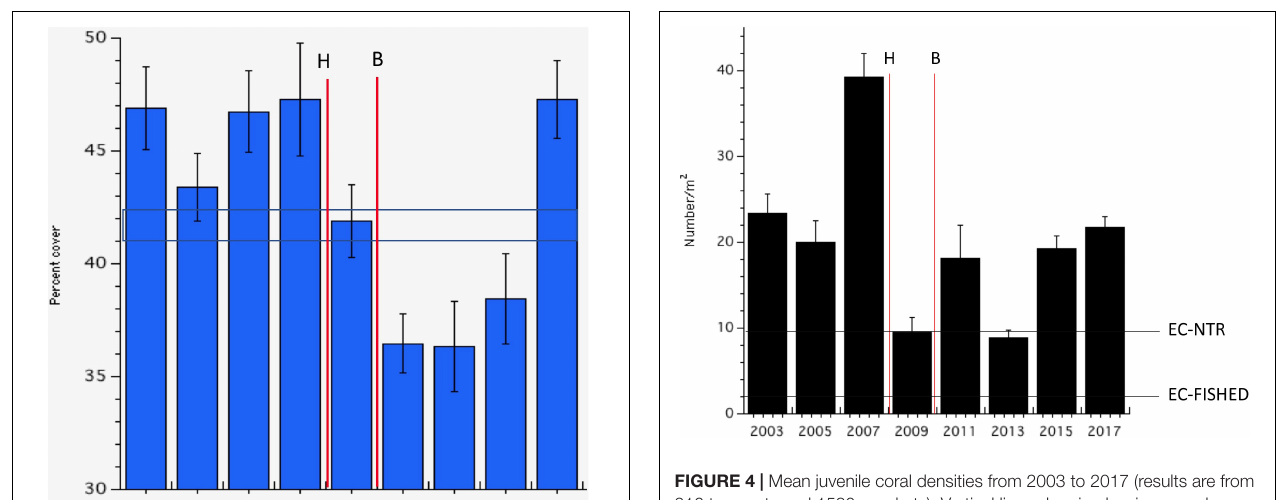
( Supplementary Figure S2 ). Nevertheless, the average percent cover of macroalgae at all study areas of the Eastern Caribbean was 25%, four times higher than that recorded for Bonaire (Steneck et al., 2018).